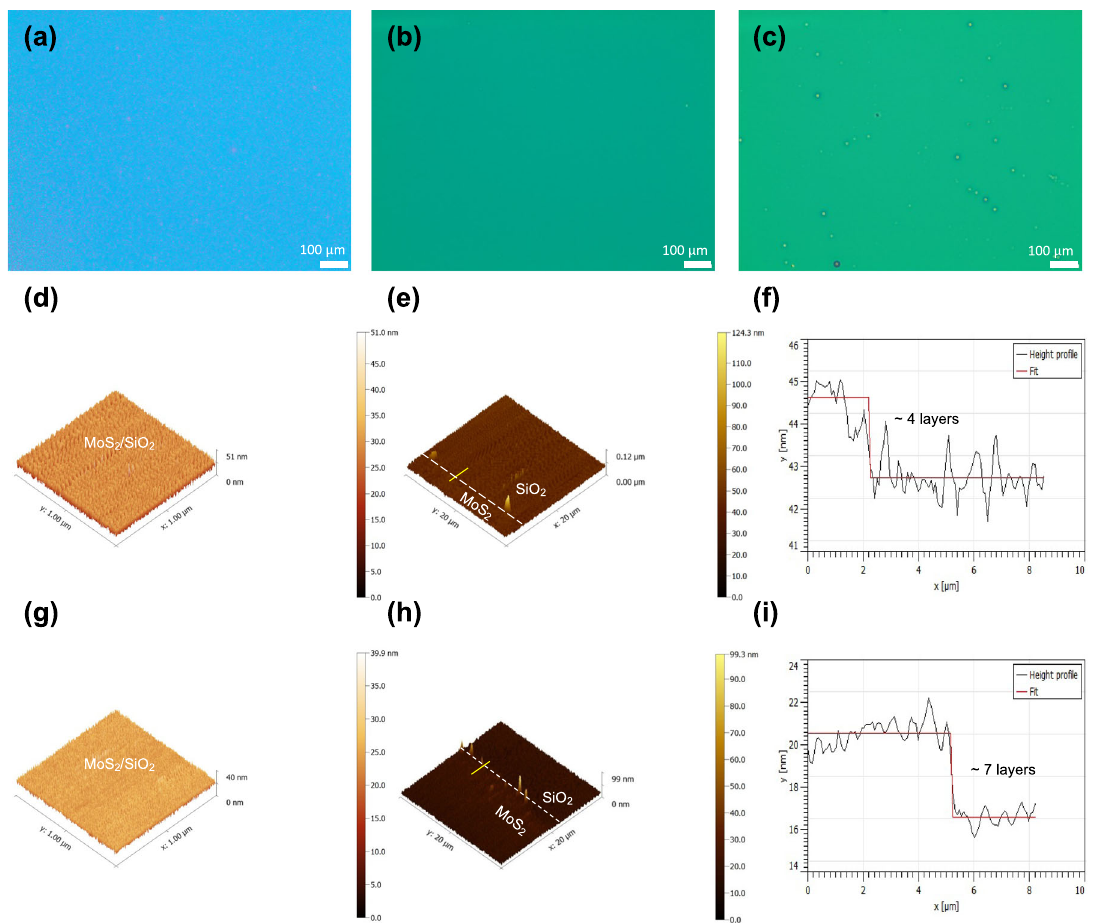
Fig. 3 AFM analyses of spin-coated MoS 2 fi lms. a – c Optical images of spin-coated MoS 2 fi lms from three concentrations: 0.0065, 0.0125, and 0.025 M, d – f AFM images and high pro fi le of fi lms from 0.0125 M and g – i 0.025 M (scale bar: 100 μ